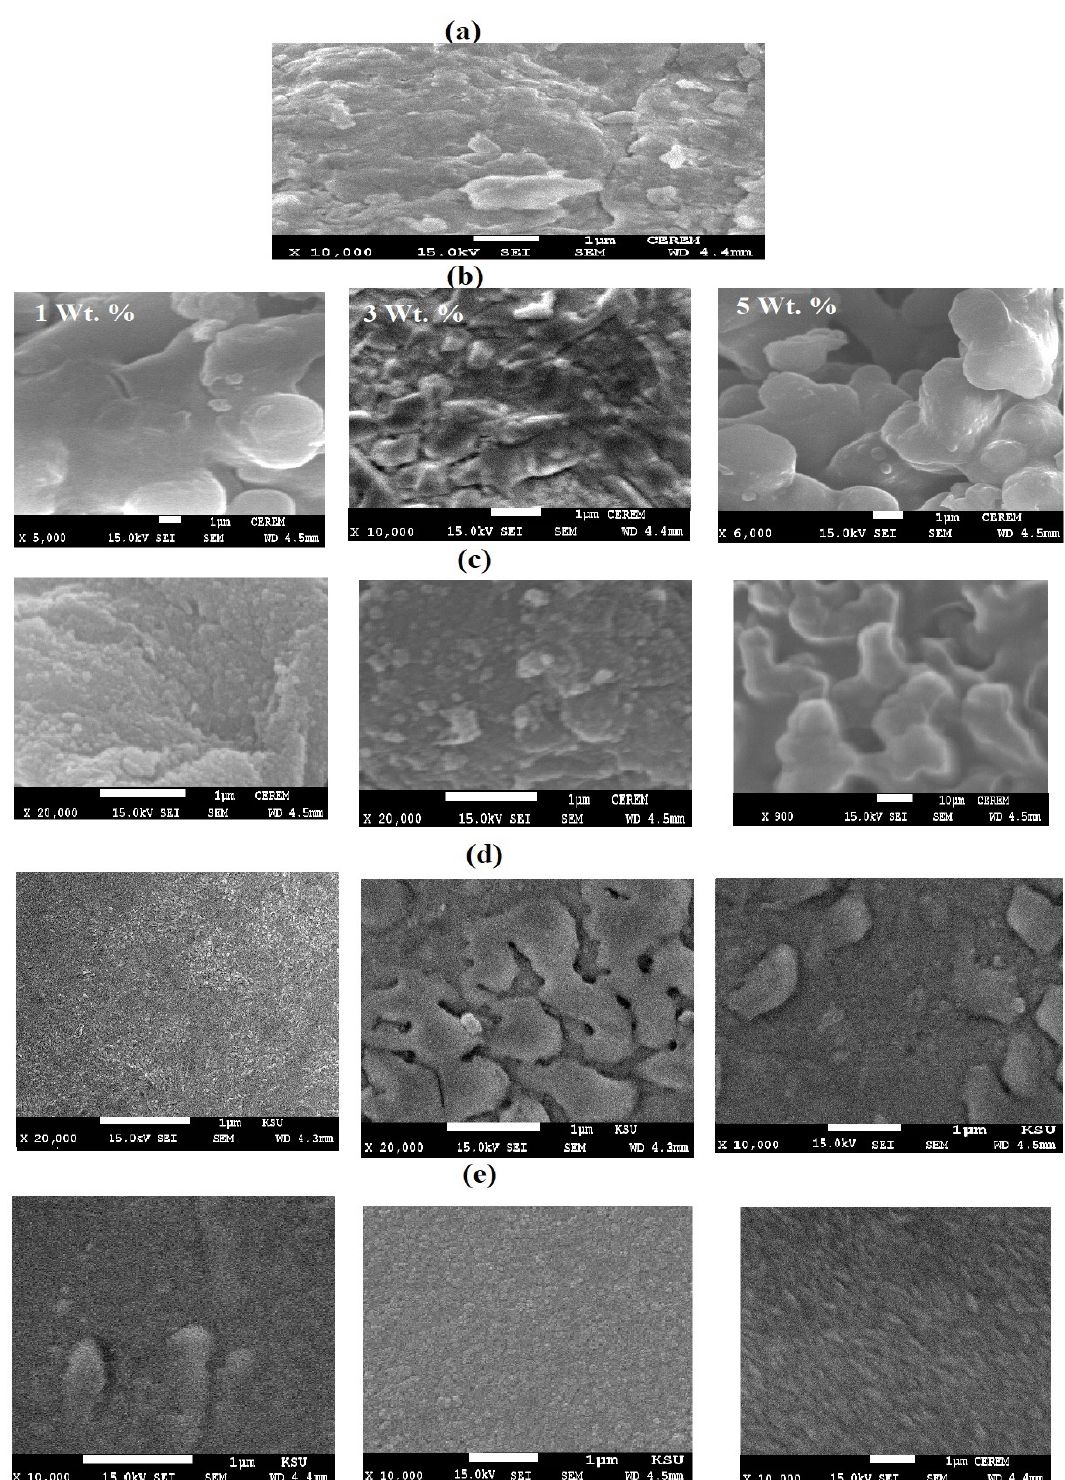
Figure 6. SEM images of the cured epoxy/polyamine hardener different wt.% of filler. From left to right 1, 3, 5 wt.% of ( a ) absence of filler, ( b ) SG, ( c ) AS, ( d ) STHa and ( e ) STHc.